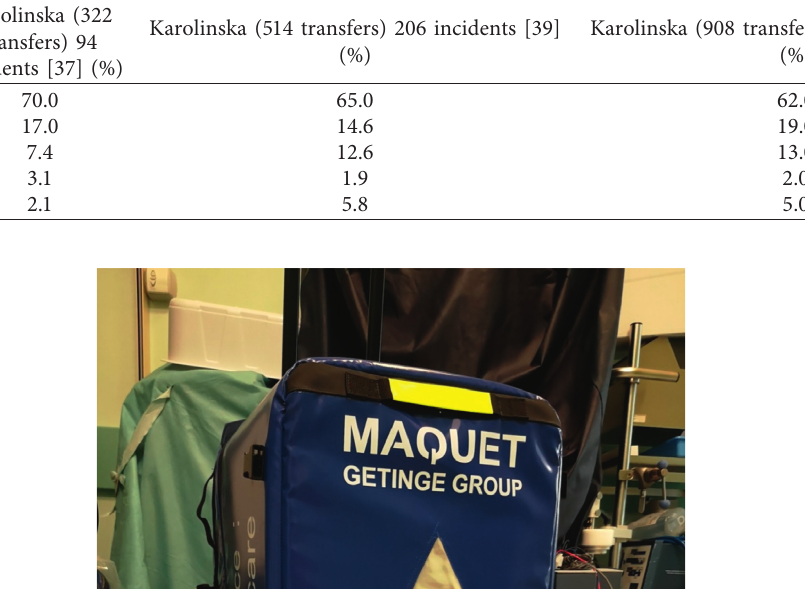
Table 3: Sources of adverse events according to the typology of Broman et al. along with the percentage distribution after detailed analysis of 322, 514, and 908 transfers.